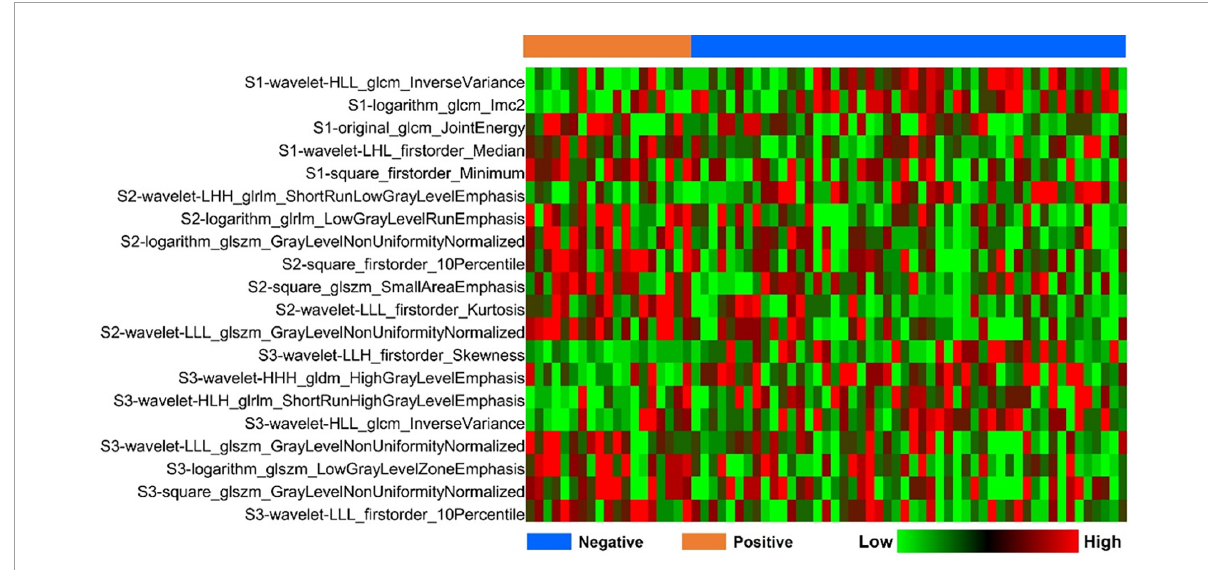
FIGURE4 Heatmap analysis of the selected radiomic features. Each column corresponds to one patient, and each row represents one radiomic